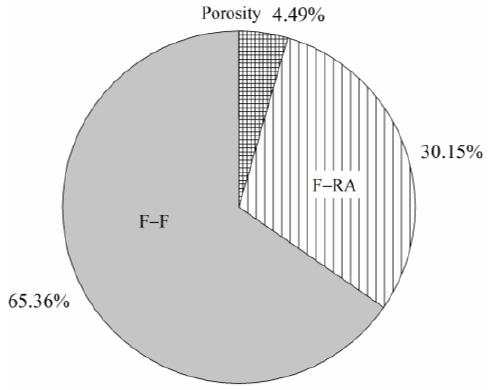
Figure 14. The pie chart of the present prior particle boundaries in admixed PM steels (F–F = Ferrite– Ferrite boundary; F–RA = Ferrite–Retained Austenite boundary).